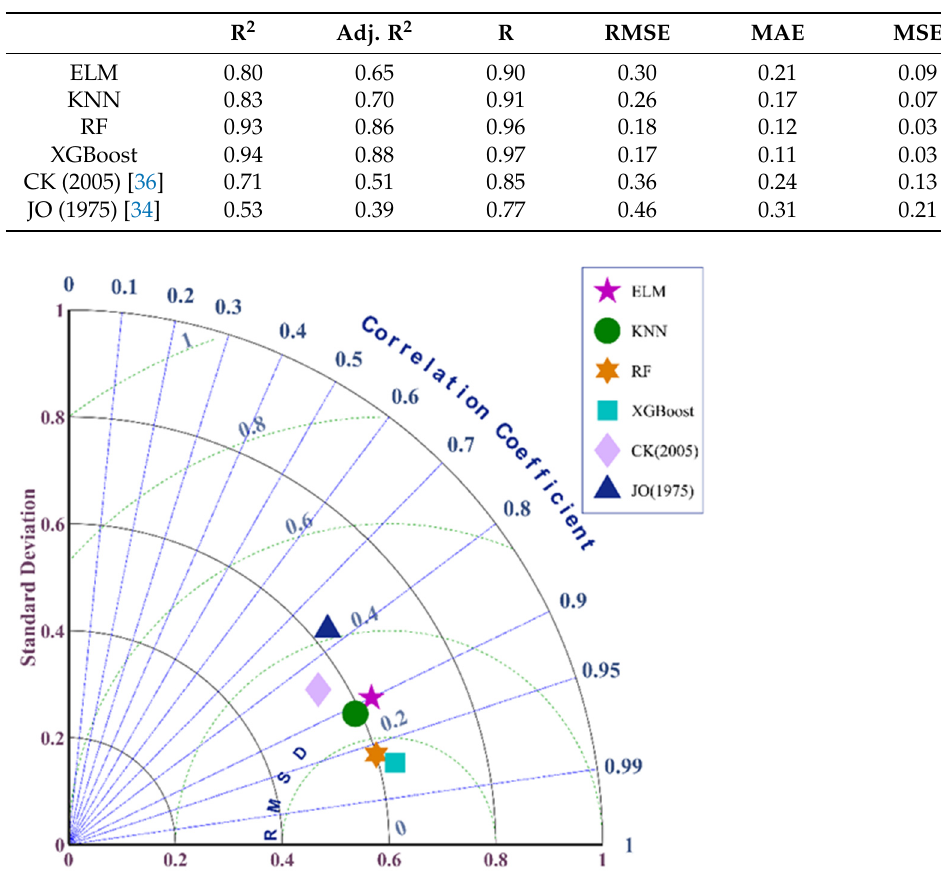
Table 4. Test performance of six models.